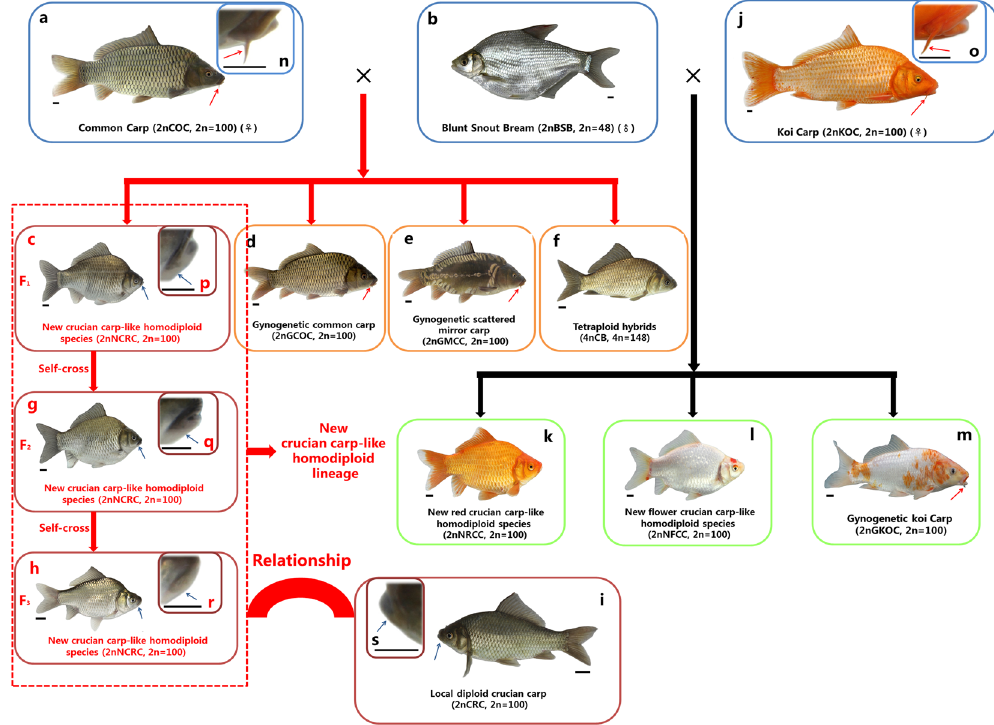
Figure 1. Crossing procedure, appearance of 2nCOC, 2nBSB and their offspring, appearance of 2nKOC, 2nBSB and their offspring, and appearance of local diploid crucian carp. ( a ) 2nCOC. ( b ) 2nBSB. ( c ) 2nNCRC offspring of 2nCOC ( ♀ ) × 2nBSB ( ♂ ). ( d ) 2nGCOC offspring of 2nCOC ( ♀ ) × 2nBSB ( ♂ ). ( e ) 2nGMCC offspring of 2nCOC ( ♀ ) × 2nBSB ( ♂ ). ( f ) 4nCB offspring of 2nCOC ( ♀ ) × 2nBSB ( ♂ ). ( g ) Self-cross offspring of 2nNCRC (2nNCRC-F 2 ). ( h ) Self-cross offspring of 2nNCRC-F 2 (2nNCRC-F 3 ). ( i ) Local diploid crucian carp (2nCRC). ( j ) Koi carp (2nKOC). ( k ) Red crucian carp-like homodiploid fish (2nNRCC). ( l ) Flower crucian carp-like homodiploid fish (2nNFCC). ( m ) Gynogenetic koi carp (2nGKOC). ( n ) Amplification of the head of 2nCOC ( a ). ( o ) Amplification of the head of 2nKOC ( j ). ( p ) Amplification of the head of 2nNCRC ( c ). ( q ) Amplification of the head of 2nNCRC-F 2 ( g ). ( r ) Amplification of the head of 2nNCRC-F 3 ( h ). ( s ) Amplification of the head of 2nCRC ( i ). The red arrows indicate barbels, and the blue arrows indicate barbel loss. Scale bars in a–s, 1